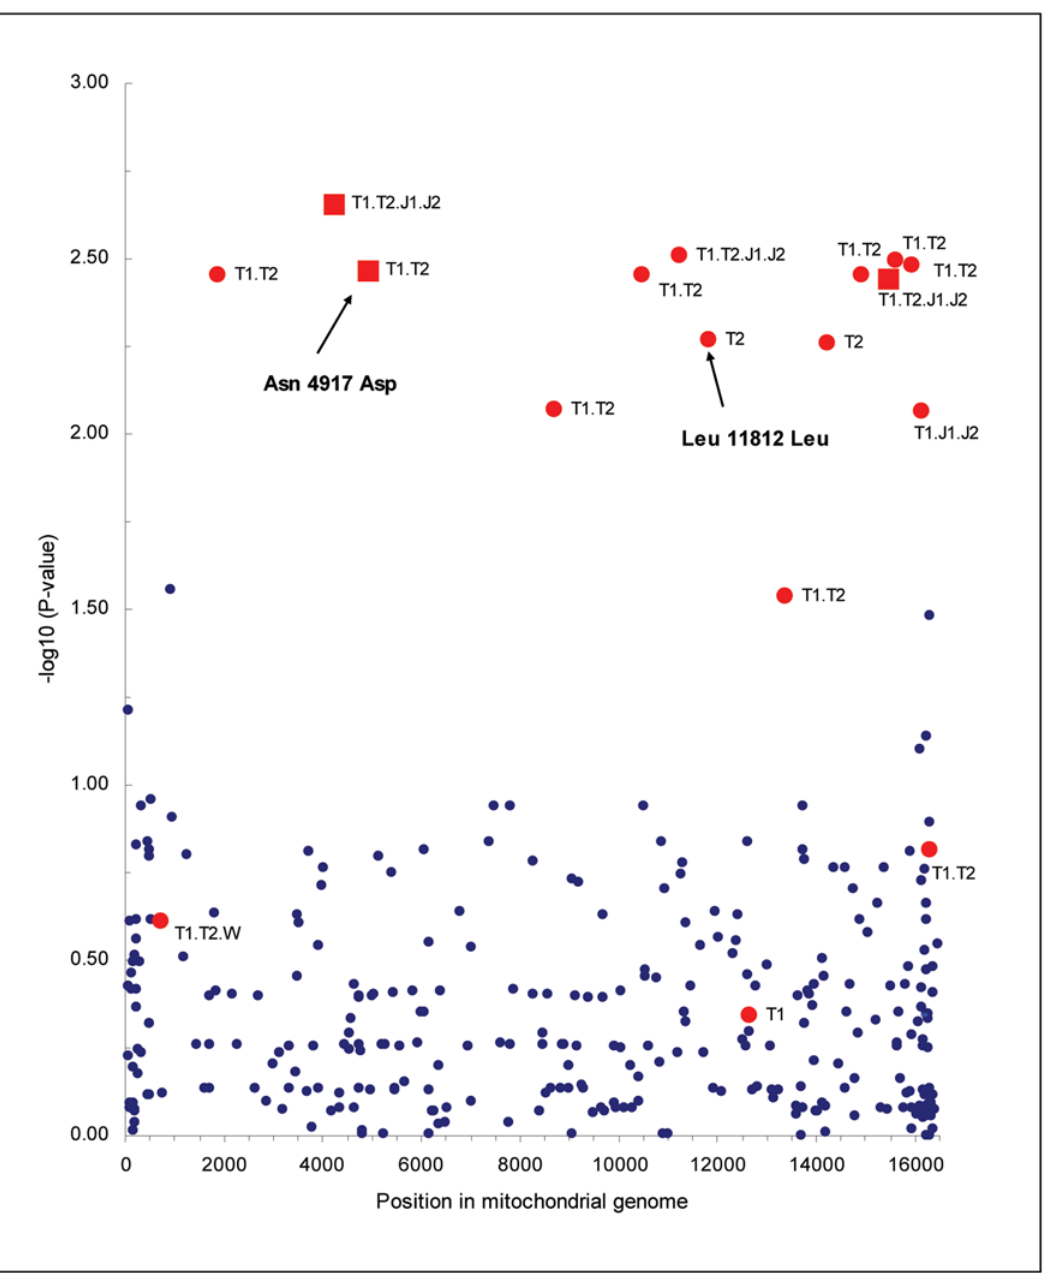
Figure 1. Distribution of age- and sex-adjusted P-values for all 315 mitochondrial DNA variants with minor allele frequencies . 1% from the AREDS A cohort. P -values were obtained from logistic regression analyses modeling the likelihood of having increased frequency of the less commonly observed allele in people with advanced AMD. The magnitude of 2 log 10 P-values was highest for SNPs partially or completely characterizing the T haplotype (see red symbols). Fourteen of the 17 variants in this category yielded the strongest associations in the entire sample. Among these T-haplotype-associated variants those represented by a square symbol lead to changes in protein structure. Details of these variants exist in Table 1. SNPs selected for analysis in our replication samples are indicated with